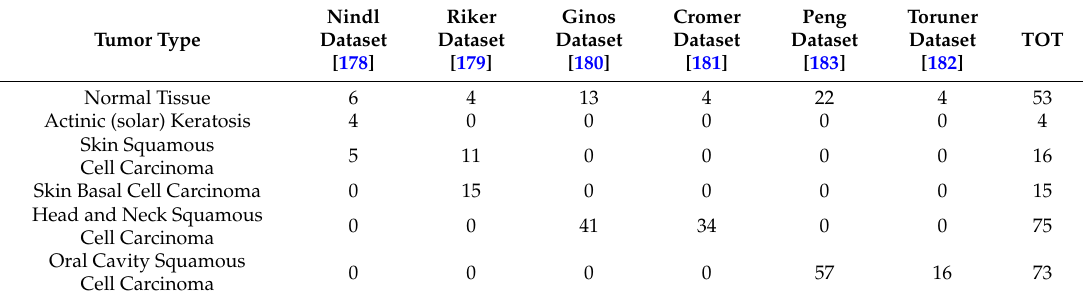
Table 1. Patient numerosity and Reference of each dataset investigated in the present study from Oncomine database